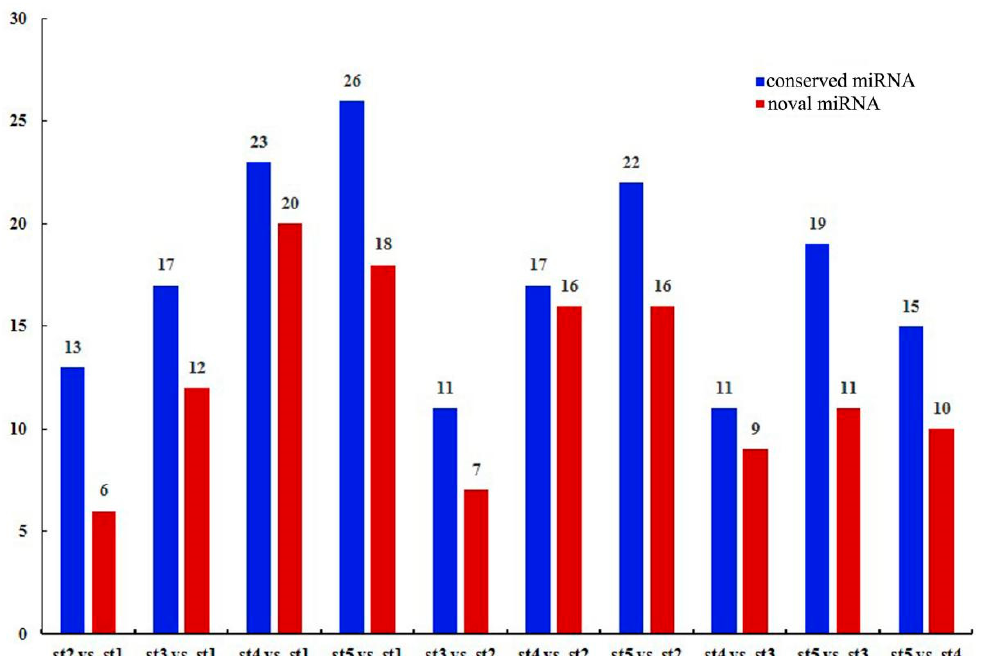
Figure 4. The number of differentially expressed miRNAs (DEMs) between two different develop- mental stages. The vertical axis reflects the numbers of DEMs, and the red and blue bars indicate the conserved and novel miRNAs, respectively.